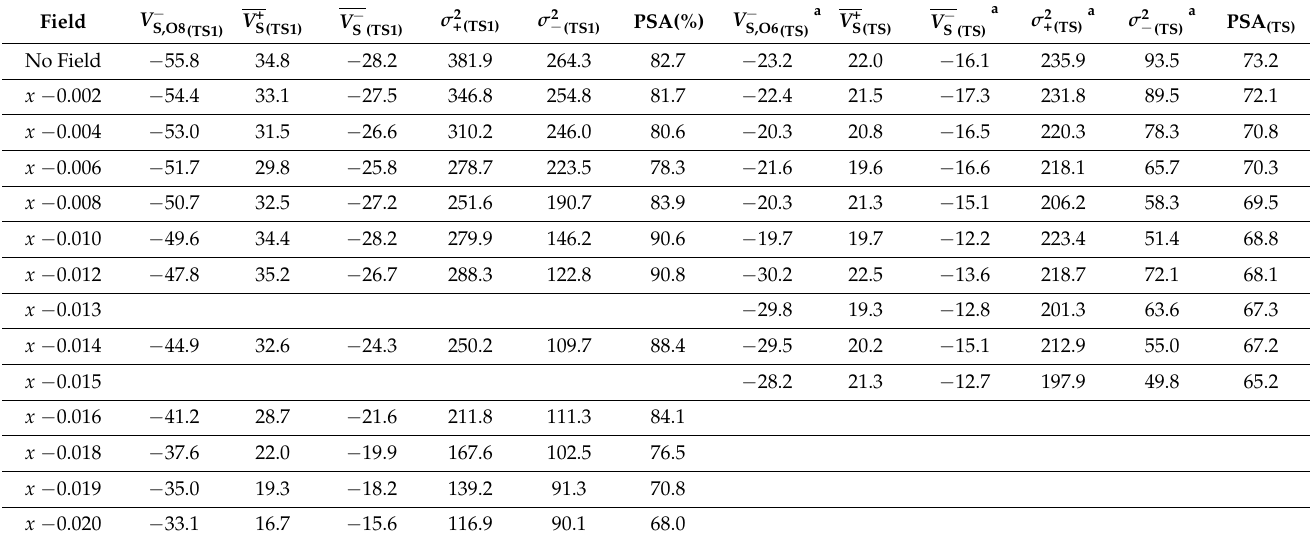
V − , kcal/mol), average positive S,O8 , kcal/mol), average S,O8 V + , V − ,kcal/mol), and their variances ( 2 σ + and 2 σ − , V − , kcal/mol), and their variances S S S S